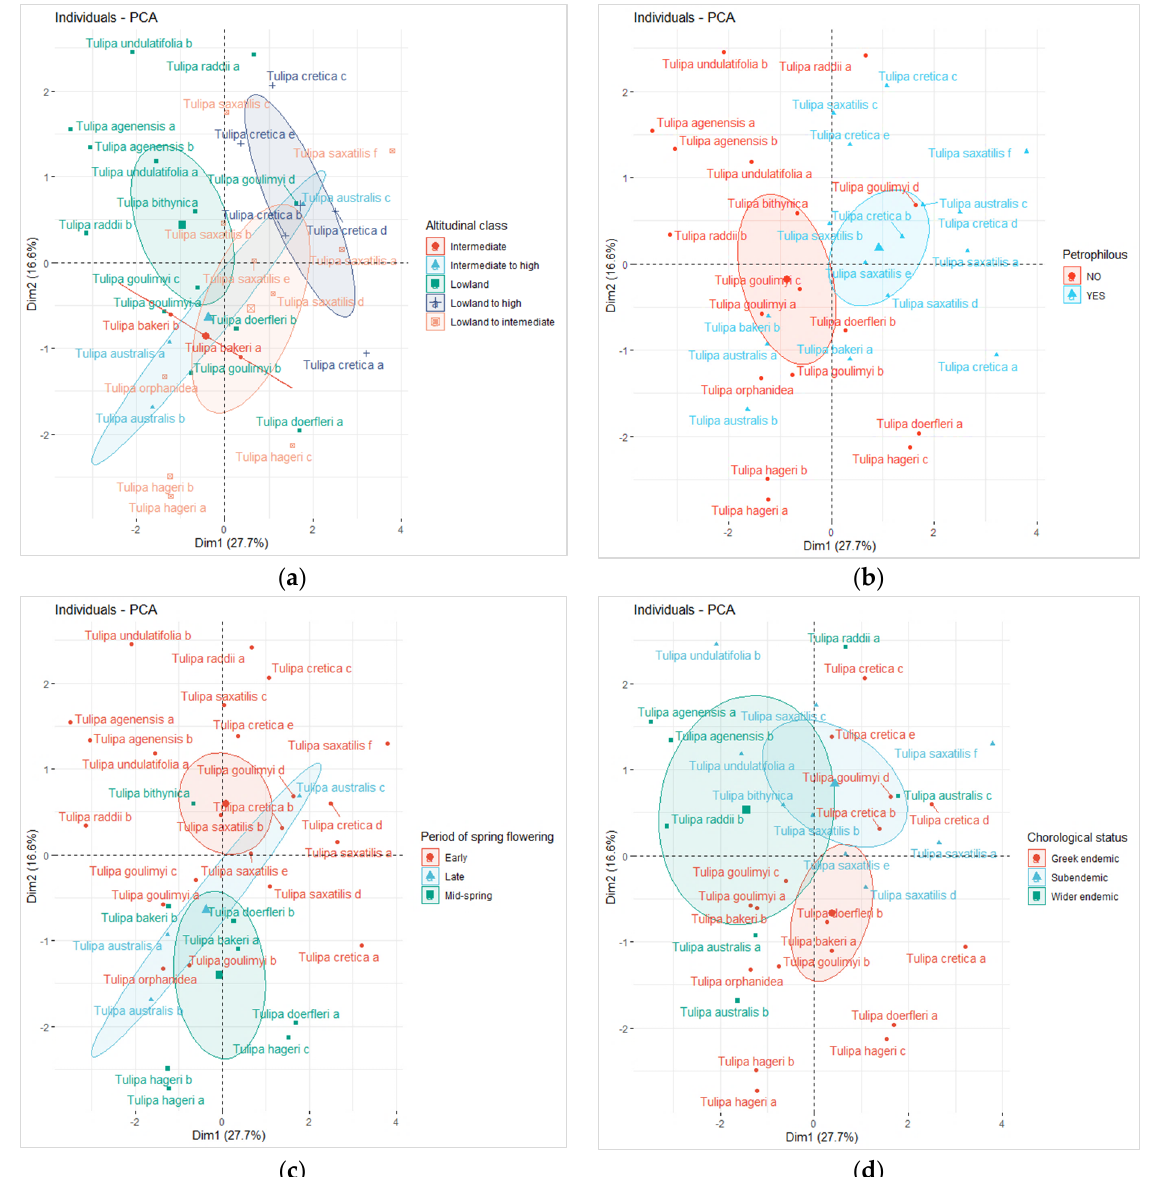
Figure 6. Distribution of each sampled tulip species as scattered betweem the first two components of the PCA (95% confidence ellipses), and respective grouping in terms of ( a ) different altitudinal classes; ( b ) rock-dwelling habit or not (petrphilous); ( c ) period of spring flowering; and ( d ) chorological status.